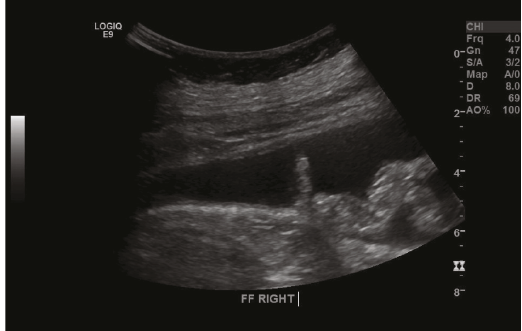
Figure 2: US of the abdomen. Free fl uid in the right paracolic gutter.